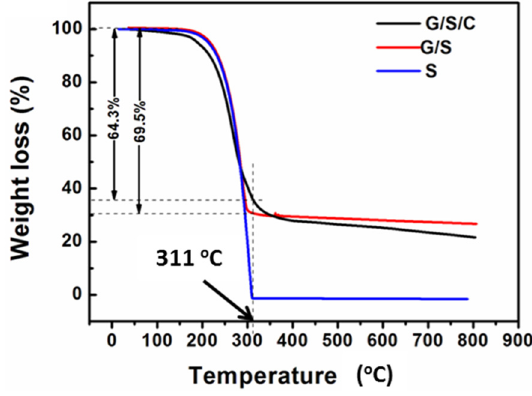
Figure 3. Thermogravimetric (TG) curves of G/S/C, G/S and pure